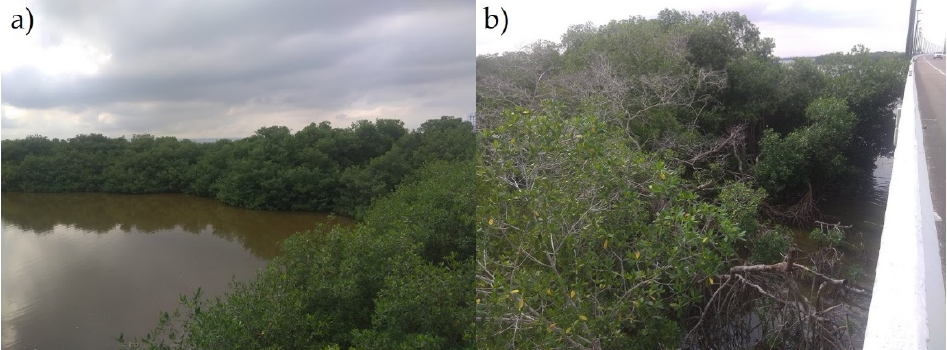
Figure 8. ( a ) Mangroves ( R. mangle ) in good condition in the west sector of La Virgen Swamp; ( b ) mangrove cutting due to the construction of the viaduct over La Virgen Swamp.